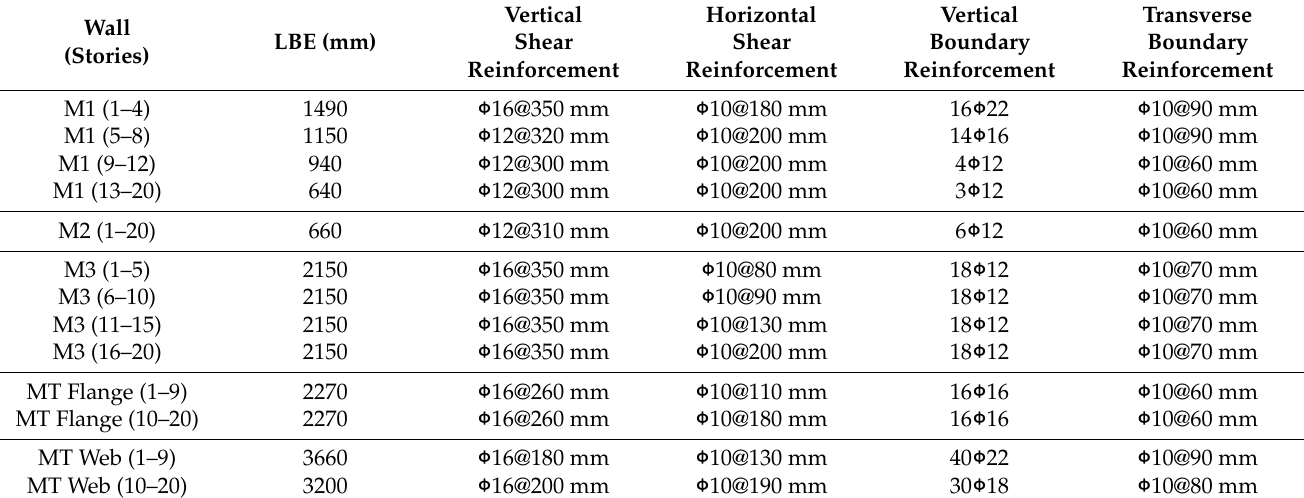
Table 1. Properties of the buildings’ seismic design.